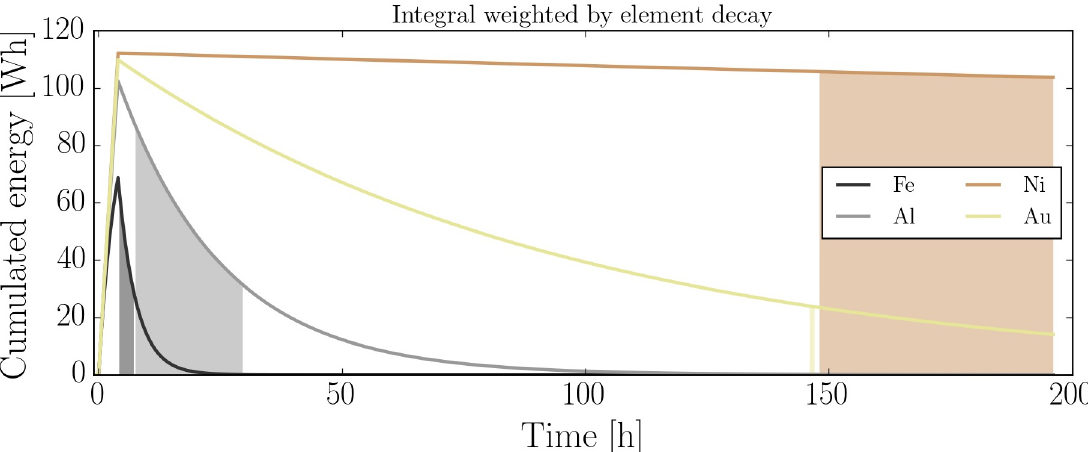
Figure 3: Integral of the power as seen by the dosimeters, with the period in the HPGe represented with the large